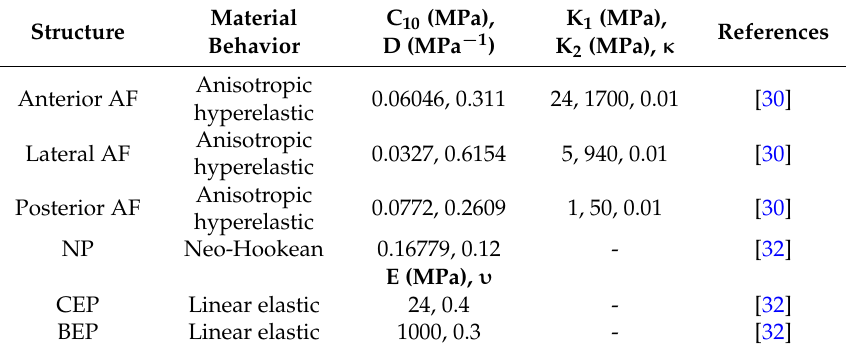
Table 1. Material behavior of the components of the intervertebral disc (IVD).